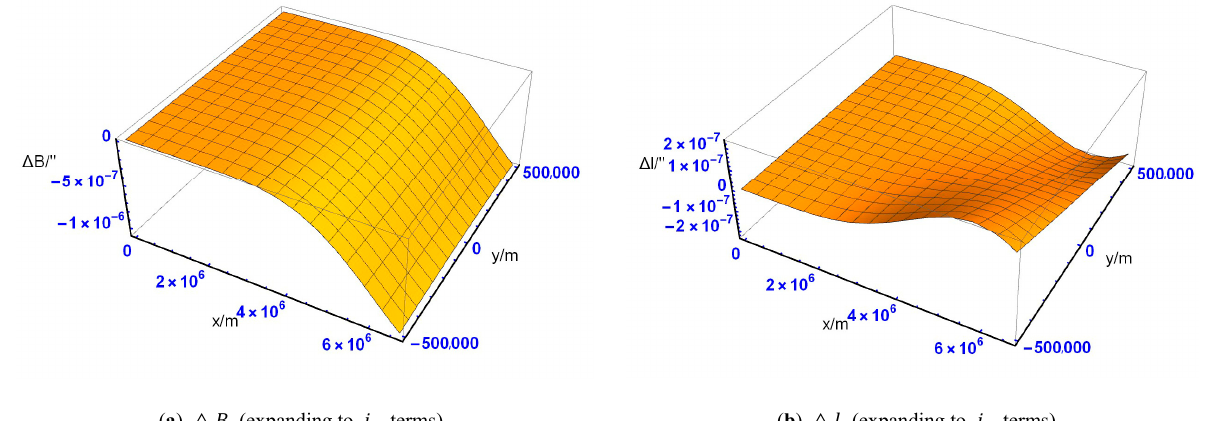
Figure 13. The distribution of ( ∆ x , ∆ y ) when expanding to c 5 terms (based on n ). For the inverse solution expression (11) in the form of “power exponent”, by analyzing the truncation difference of the expansion to different terms, it can be concluded that the order of magnitude of calculation difference of the inverse solution when the expression is expanded to j 5 terms is 10 − 6 . The variation trend of the latitude and longitude calculation difference ( ∆ B , ∆ l ) is shown in Figures 14 and 15: